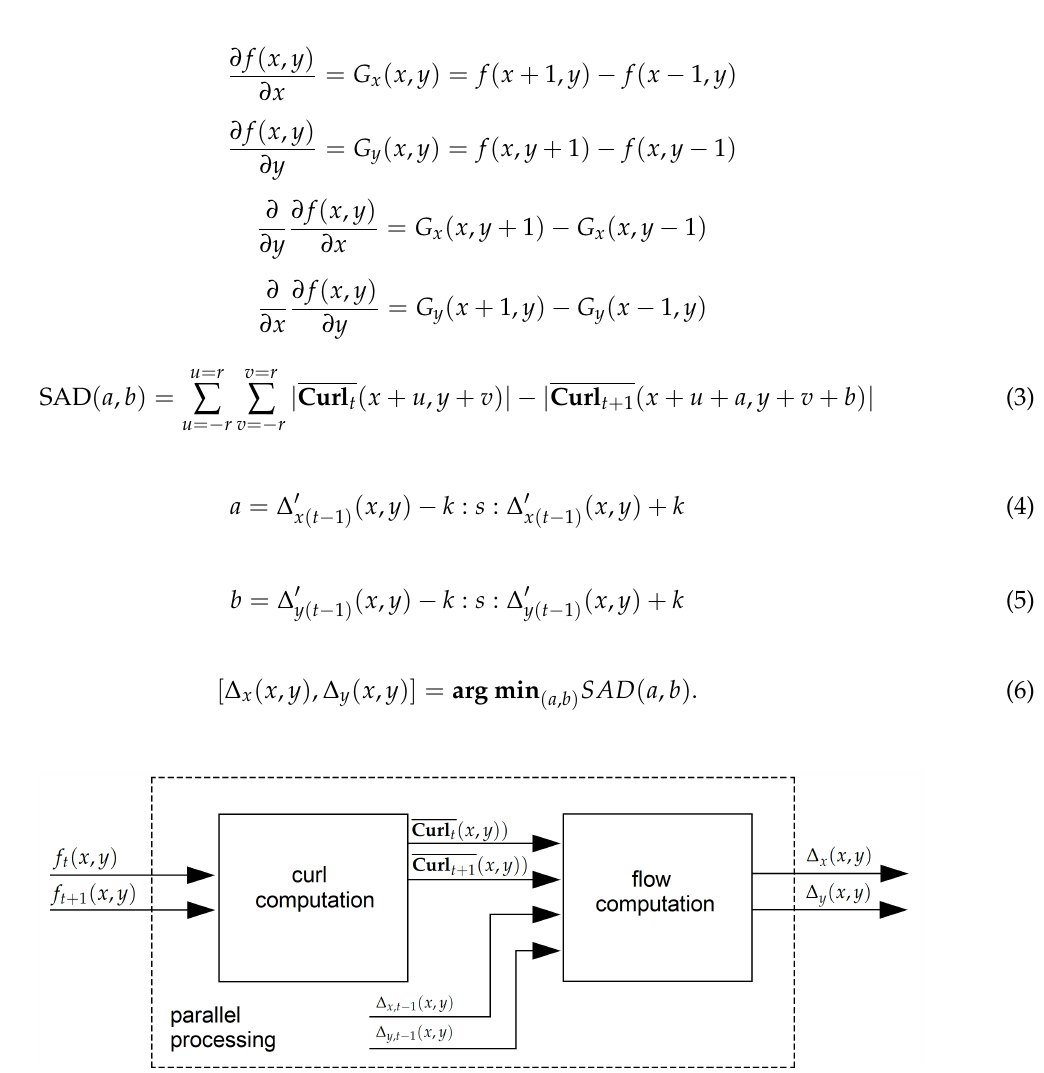
Figure 2. The optical flow step: first, curl images ( Curl t ( x , y )) , ( Curl t + 1 ( x , y )) are computed. Then, given the curl images for two consecutive frames, pixels displacements ∆ x ( x , y ) , ∆ y ( x , y ) (optical flow for all pixels in the reference image) are computed using a dynamic template based on the optical flow previously computed ( ∆ x , t − 1 ( x , y ) , ∆ y , t − 1 ( x , y )) .